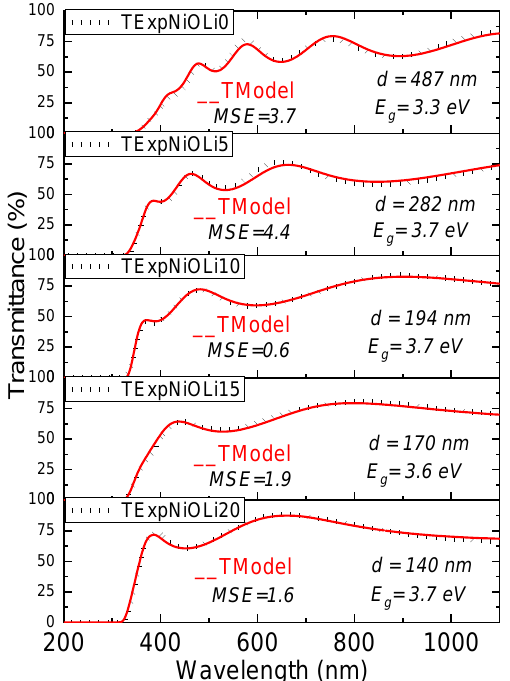
Figure 5. Experimental transmittance spectra and the best modeled transmittance for the NiO films with the different concentrations of Li in the precursor solution.